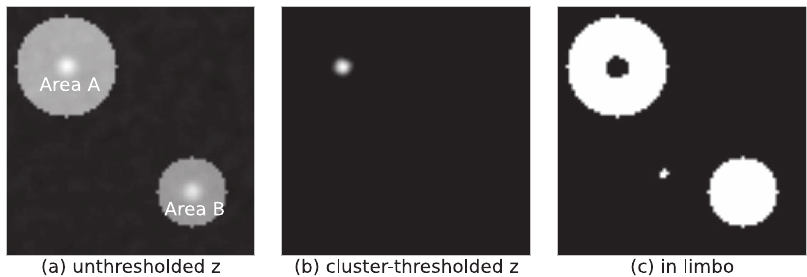
Fig. 3. Simulation results for an in limbo analysis of a single subject. In a standard fMRI analysis, some region, region A, can be identified as significantly more activated during a specific condition. For another region, region B, this effect is not significant. However, region B also does not differ significantly from region A. Hence, it is incorrect to conclude that region A is selectively activated; instead, it is appropriate to conclude that region A is activated, and region B is in limbo. See also section Simulation Studies .